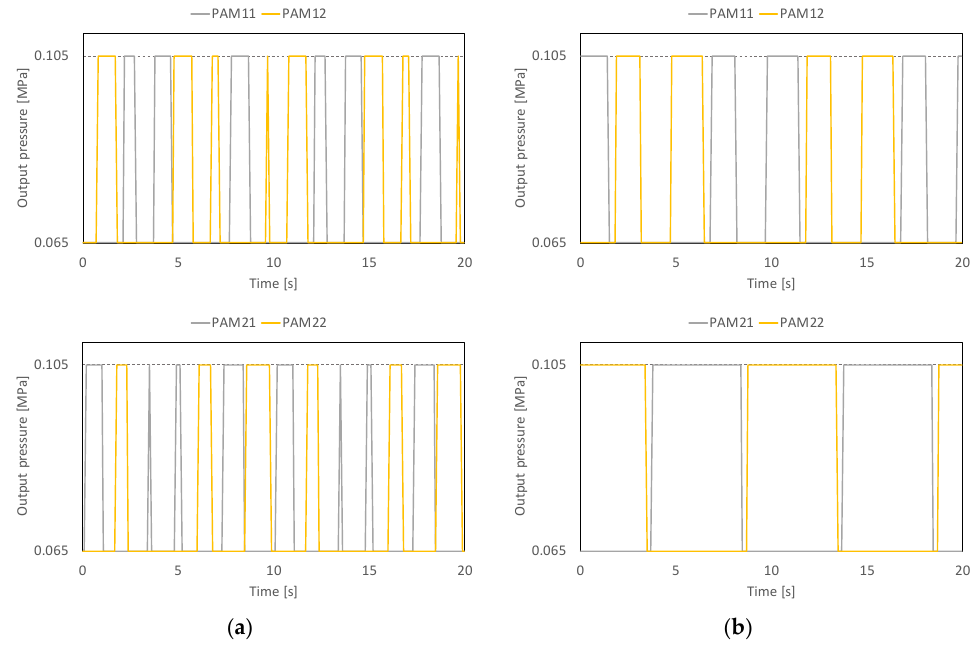
Figure 9. Cyclic inputs to PAMs using evaluation function 1 without load (( a ) first generation, ( b ) 18th generation).